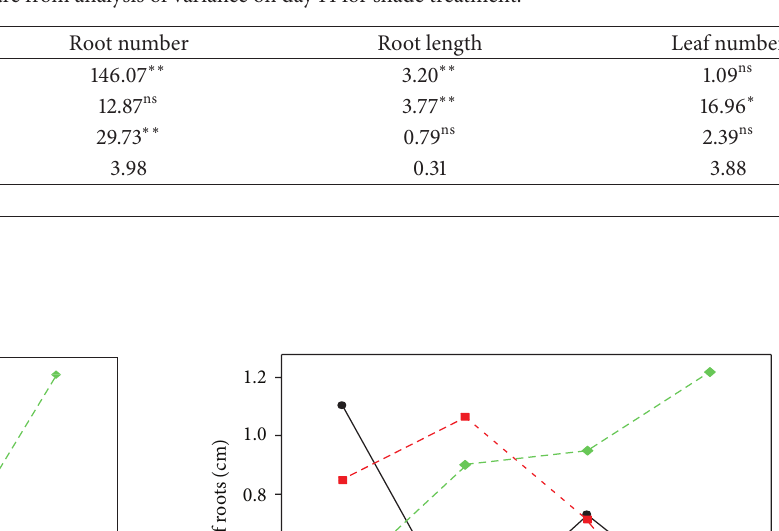
Table 16: Mean square from analysis of variance on day 14 for shade treatment.